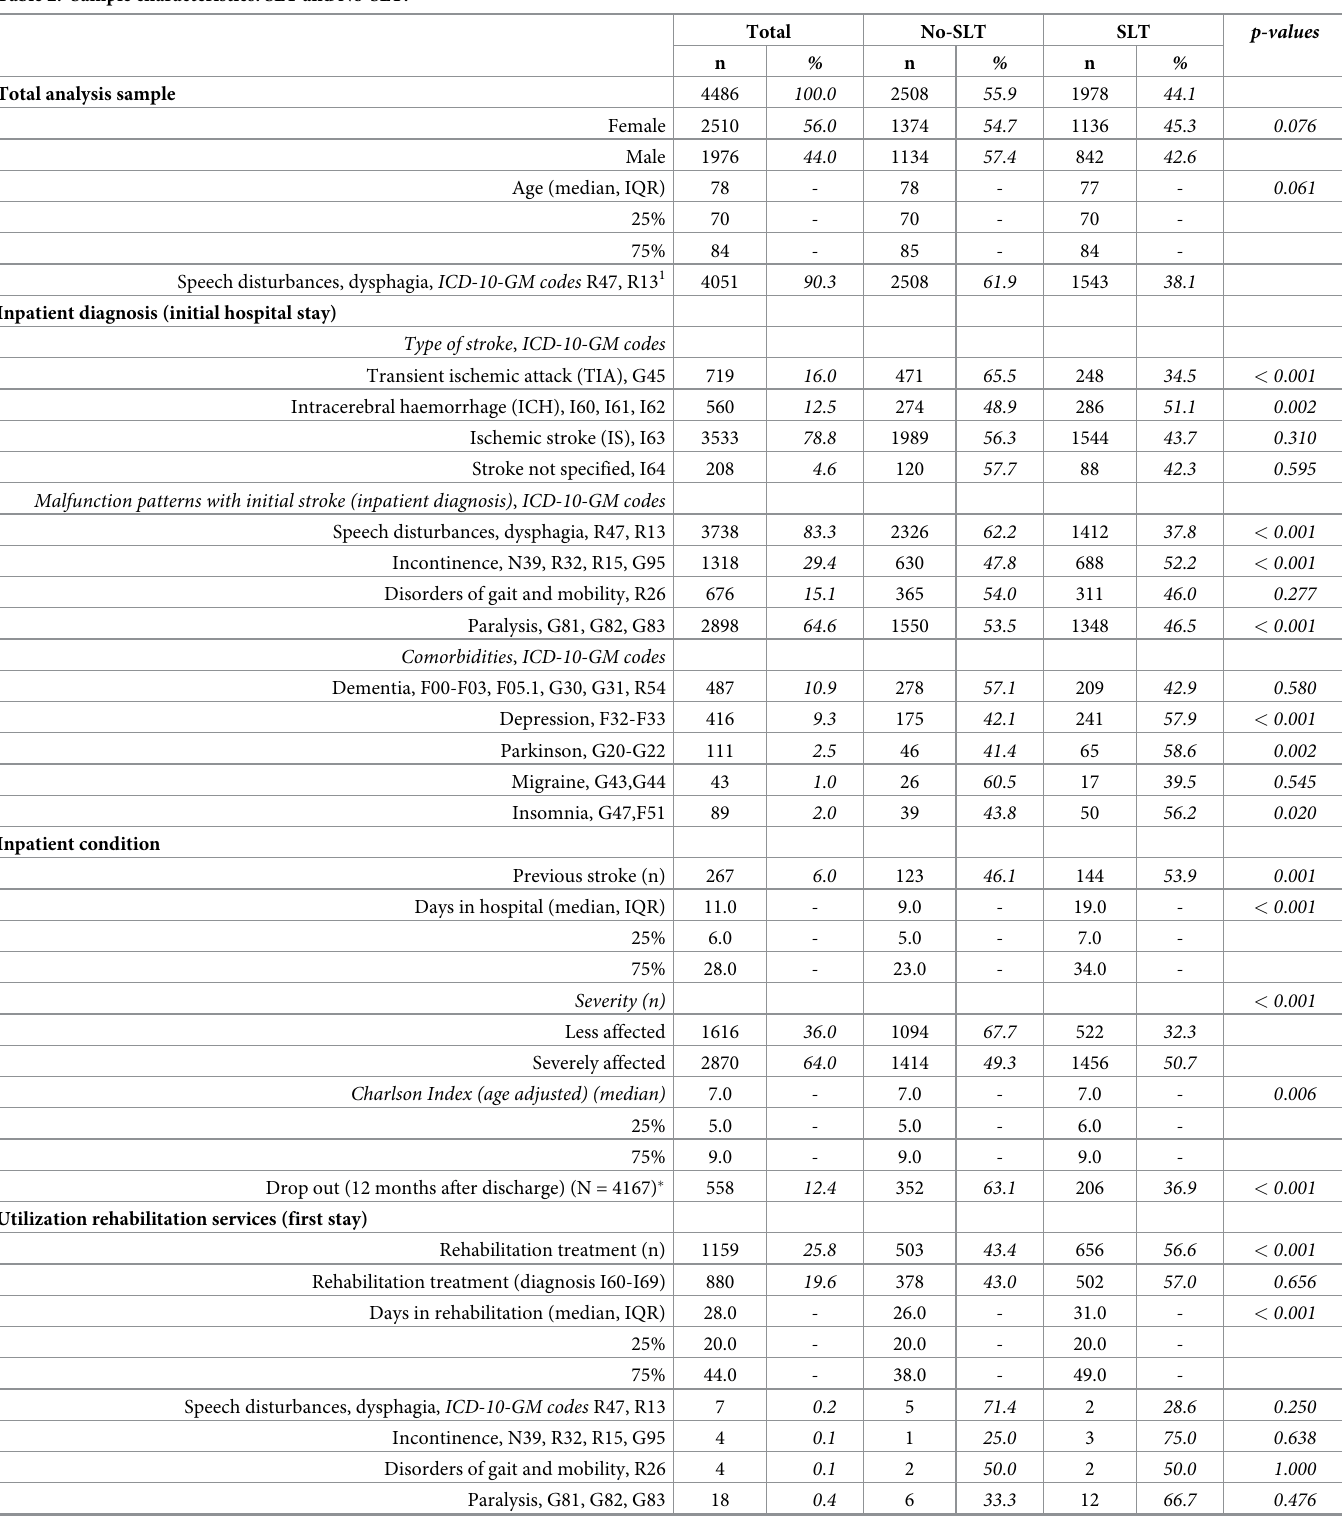
Table 2. Sample characteristics: SLT and